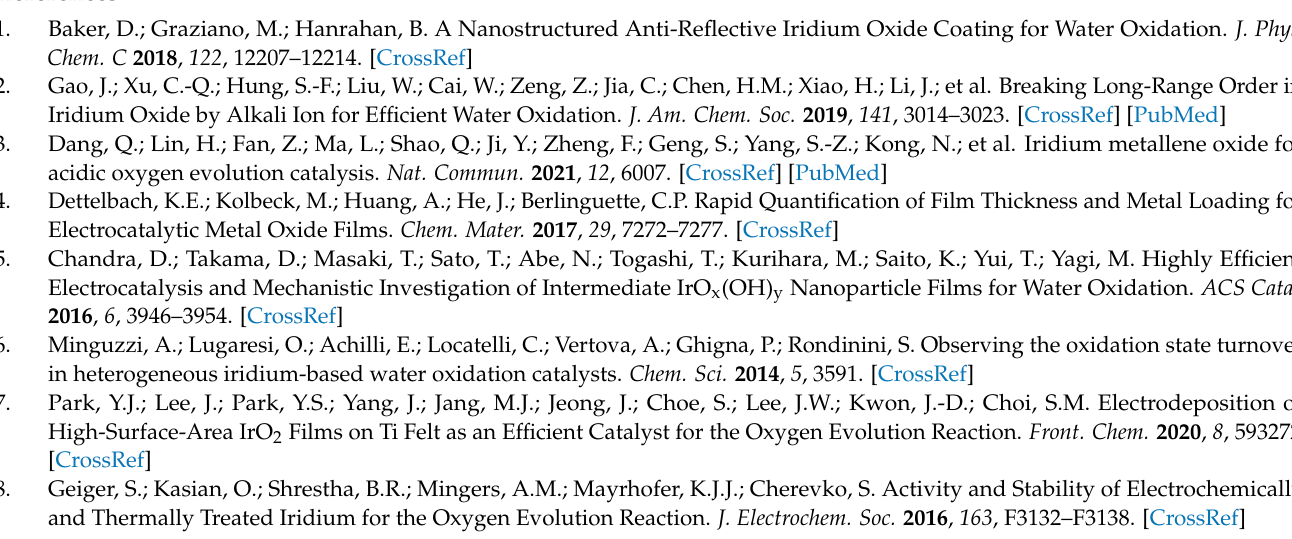
photoelectrode.; Figure S2. The variation of applied bias photon-to-current efficiency (ABPE) with the applied potential for the different samples; Figure S3. R ct versus film thickness of the IrO x samples; Figure S4: The total impedance versus frequency for IrO x